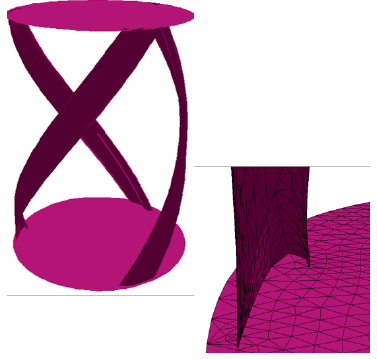
Figure 3: Gorlov Turbine (CFD